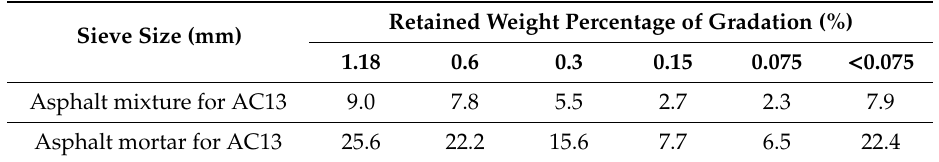
Table 1. Gradation of the asphalt mixture and corresponding mortar .